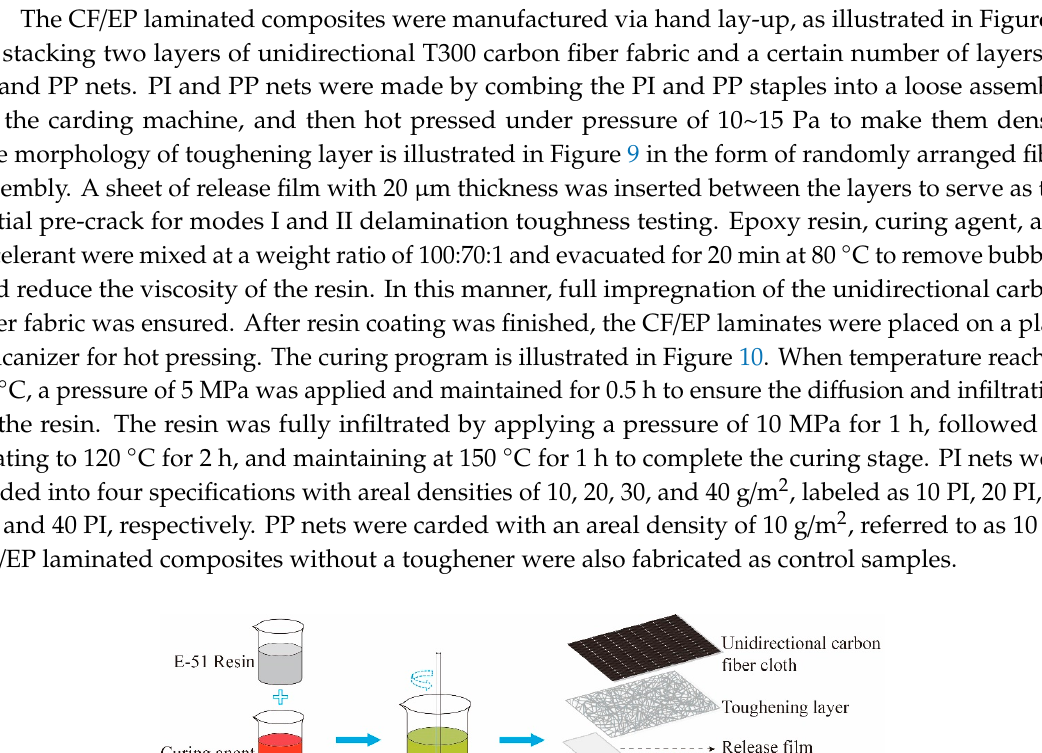
Figure 10. Curing program of laminated composite under hot pressing. 3.3. Mode I Interlaminar Test Mode I interlaminar fracture toughness (G IC ) was measured following ASTM D5528 [33]. A double cantilever beam (DCB) test was performed using a universal testing machine (UTM; Instron